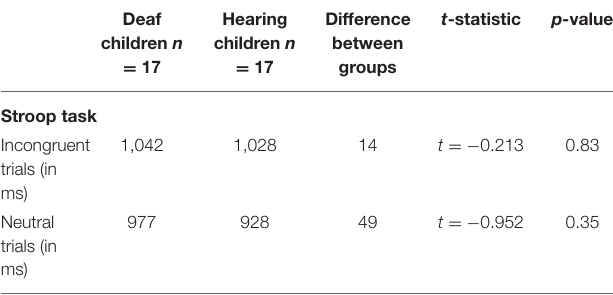
TABLE 4 | Mean reaction times obtained by deaf and hearing children on two types of Stroop